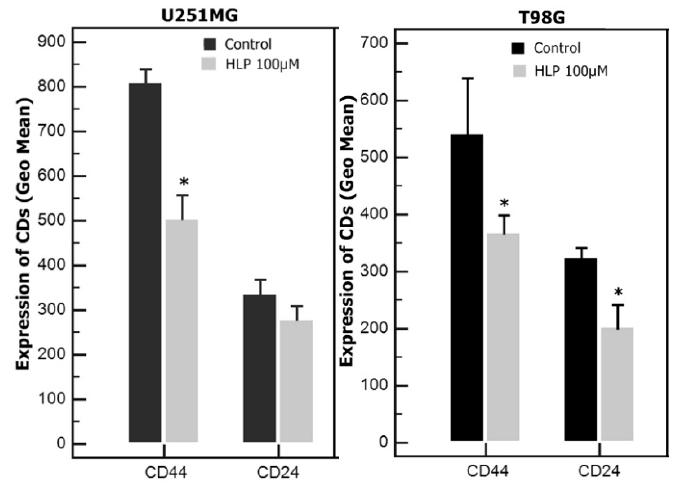
Figure 4. Flow cytometry analysis for the expression of the cluster of differentiation (CD). CD44 and CD24 expression in U251 and T98 glioblastoma cells after haloperidol treatment (HLP). Significant differences ( p < 0.05) are marked with an asterisk.